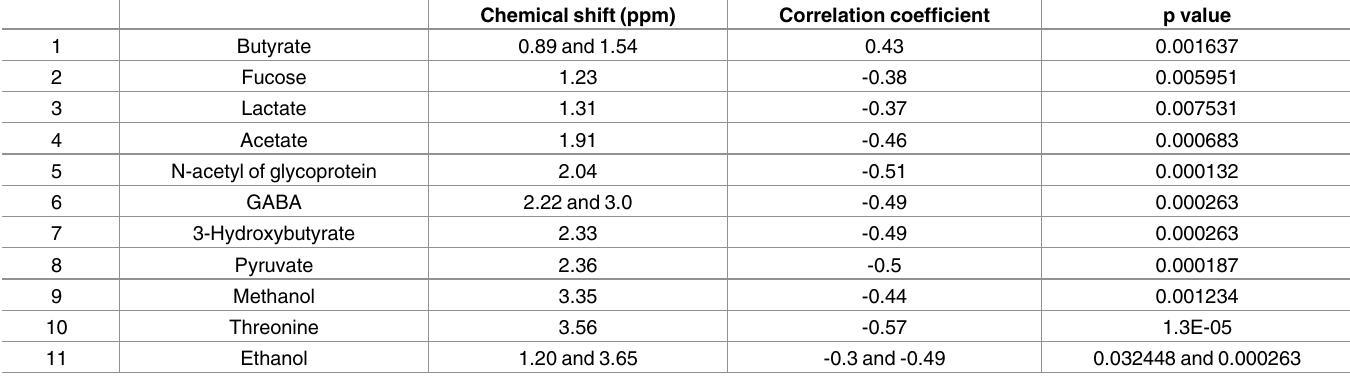
Table 2. Main metabolites identified to discriminate periodontitis from controls according to the loadings plot analysis. Correlation betweenbucket intensities and discriminated group members are given with the associatedp value.